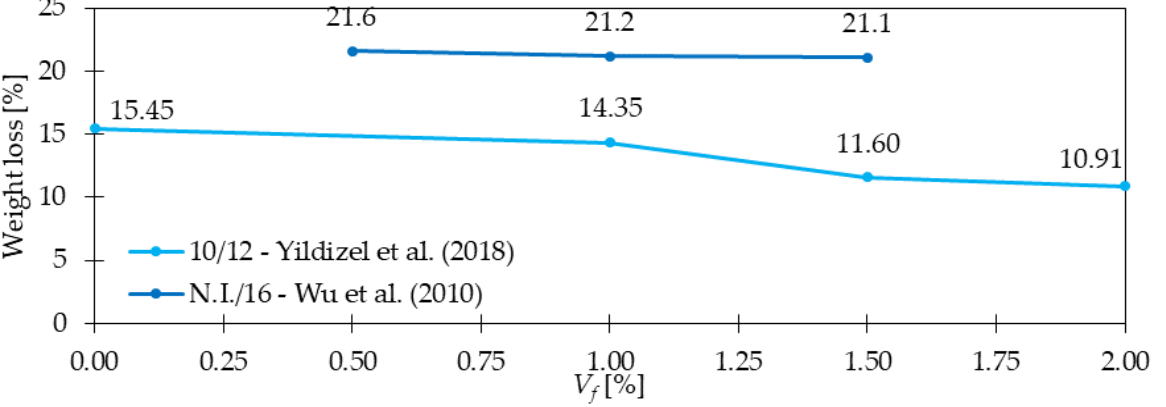
Figure 21. Weight loss in relation to V f for different fiber geometry l f /d f in flow abrasion test [98,100].